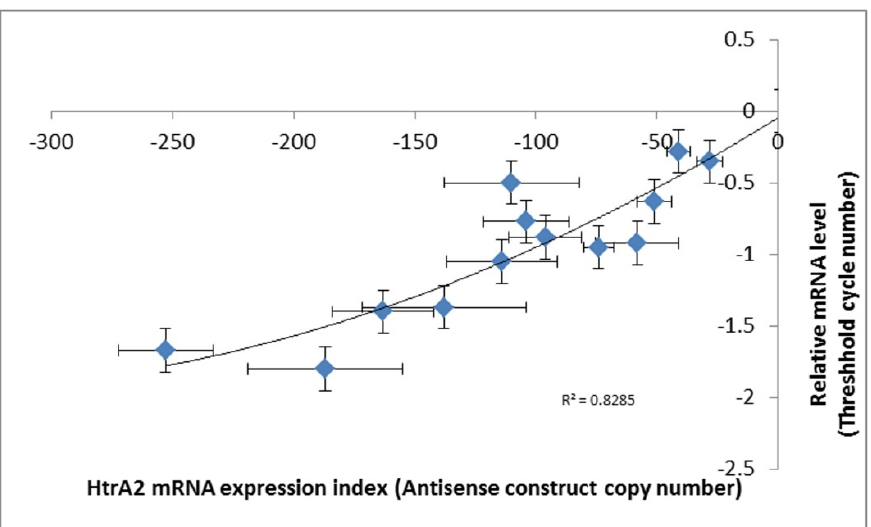
Figure 3. Expression of HTRA2 messenger RNA (mRNA) correlates with the copy numbers of the antisense-inhibition construct, pPROF689. The copy numbers of pPROF689 in HTRA2 antisense-inhibited transformants were measured by quantitative PCR (qPCR) and ranged from 28 to 252. The transcription of htrA was strongly correlated with the pPROF689 copy number ( p = 6.2 × 10 − 5 , quadratic regression, F test, n = 13). Error bars are standard errors from three independent experiments, each involving duplicate measurements. The previously established convention of using negative numbers for the antisense expression index was followed, so that htrA mRNA expression levels increase from left to right.